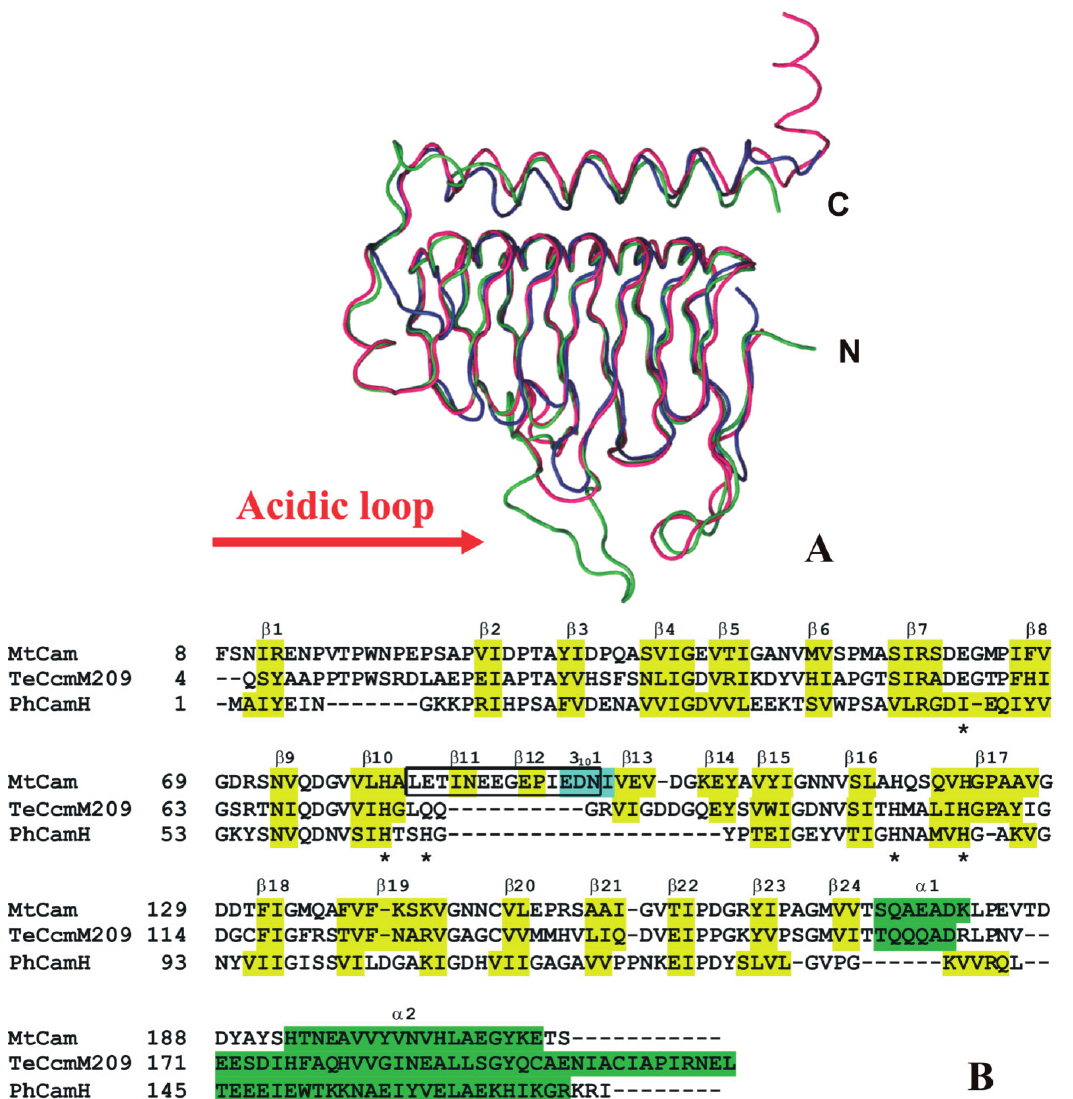
Figure 10. ( A ) Ribbon diagram showing the superposition of MtCam (blue), TeCcmM (green), and PhCamH (red) monomers; ( B ) structure-based sequence alignment of thermostable γ -CAs with known 3D structure. MtCam secondary structure elements are indicated and named according to PROMOTIF analysis [93]. α -helices, 3 10 -helices and β -strands for MtCam (PDB code 1QRG), TeCcmM209 (PDB code 3KWC), and PhCamH (PDB code 1V3W) are highlighted in green, yellow and cyan, respectively. Catalytic histidines, Glu84 and Glu62 of MtCam are indicated with asterisks, while the “acidic loop” (Leu83-Asn96) is